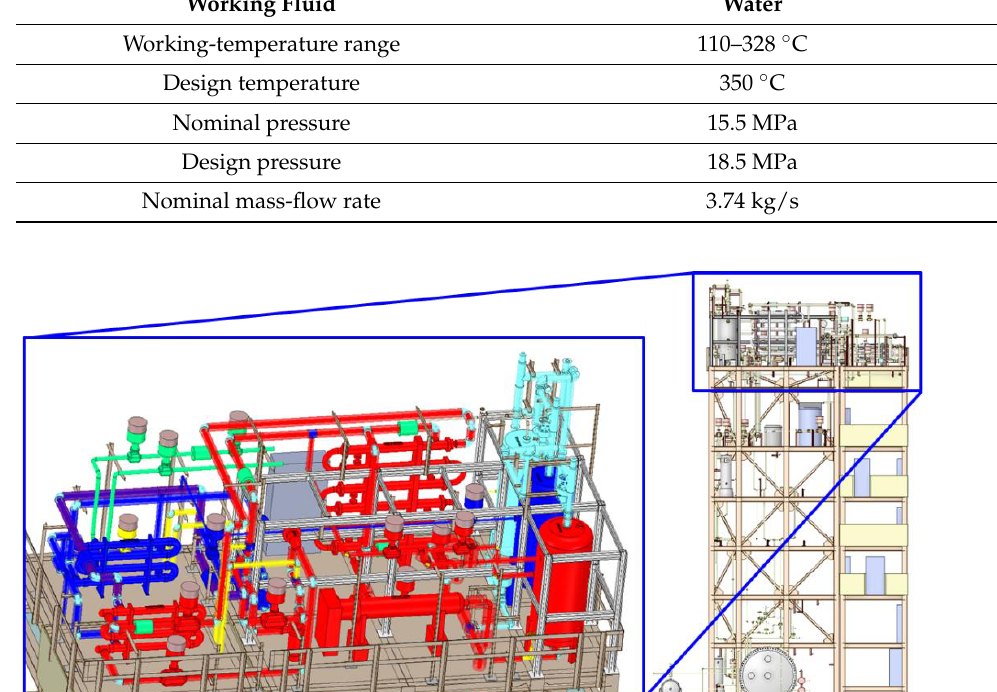
Figure 1. Overall view of WL facility and its supporting structure (red: primary loop; blue: secondary loop; green: tertiary loop).